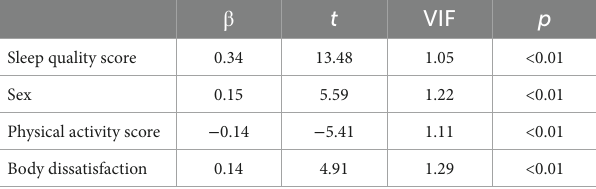
TABLE 2 Factors that contributed to depression level of university students.